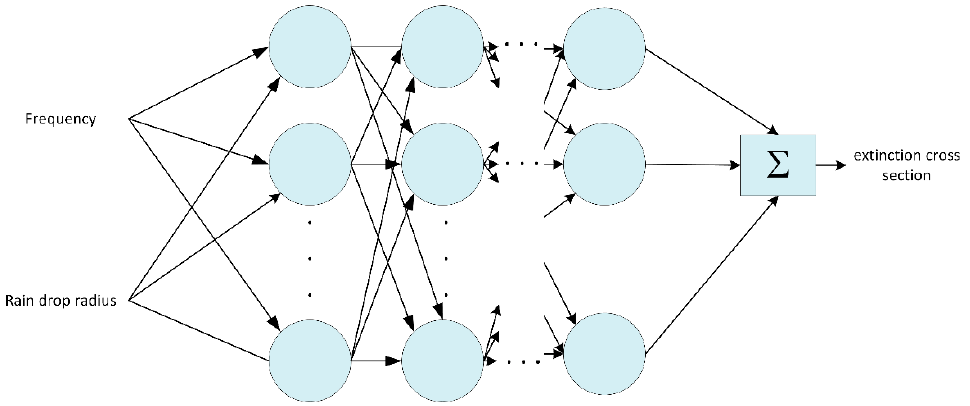
Figure 6. Adaptive ANN to predict short ‐ term rain attenuation.